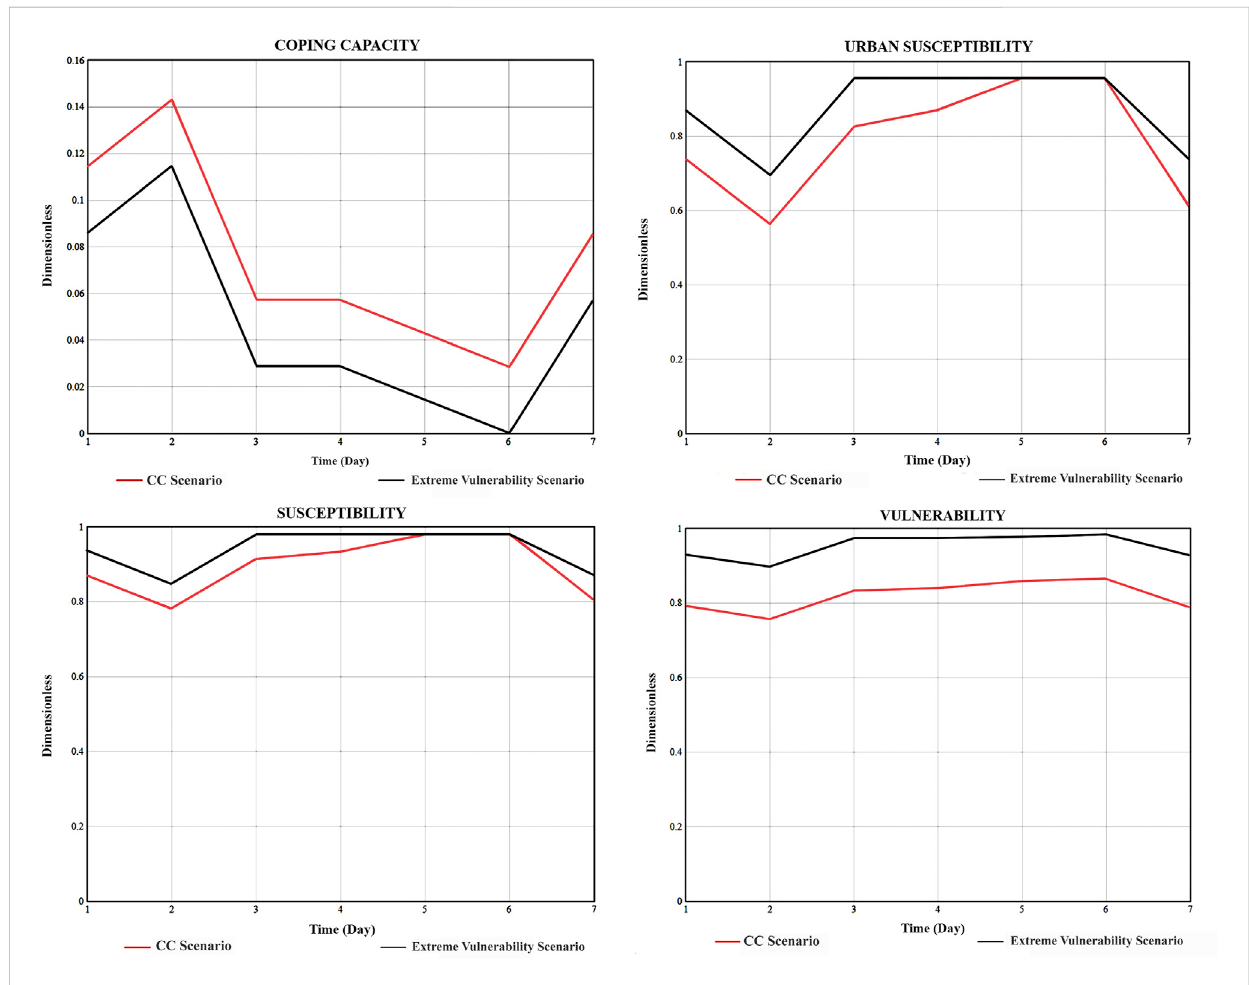
FIGURE 9 Results of Coping Capacity Scenario (CC) compared to reference scenario (Extreme